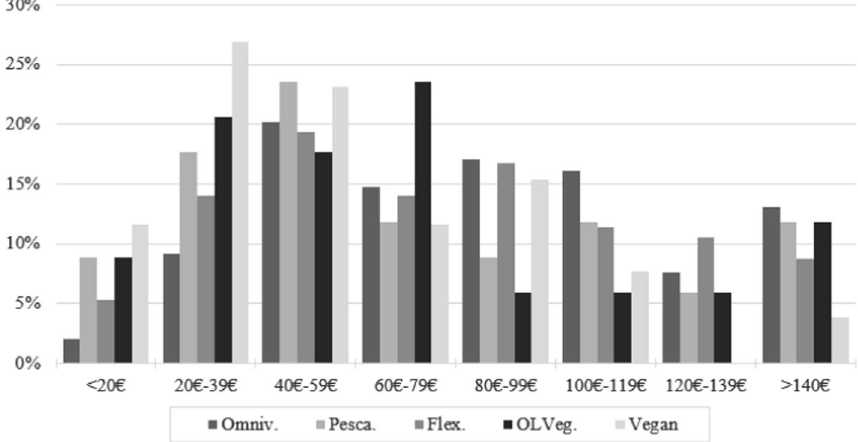
Fig. 1 Food expenditure at-home per week by actual diets (in % of consumers of each